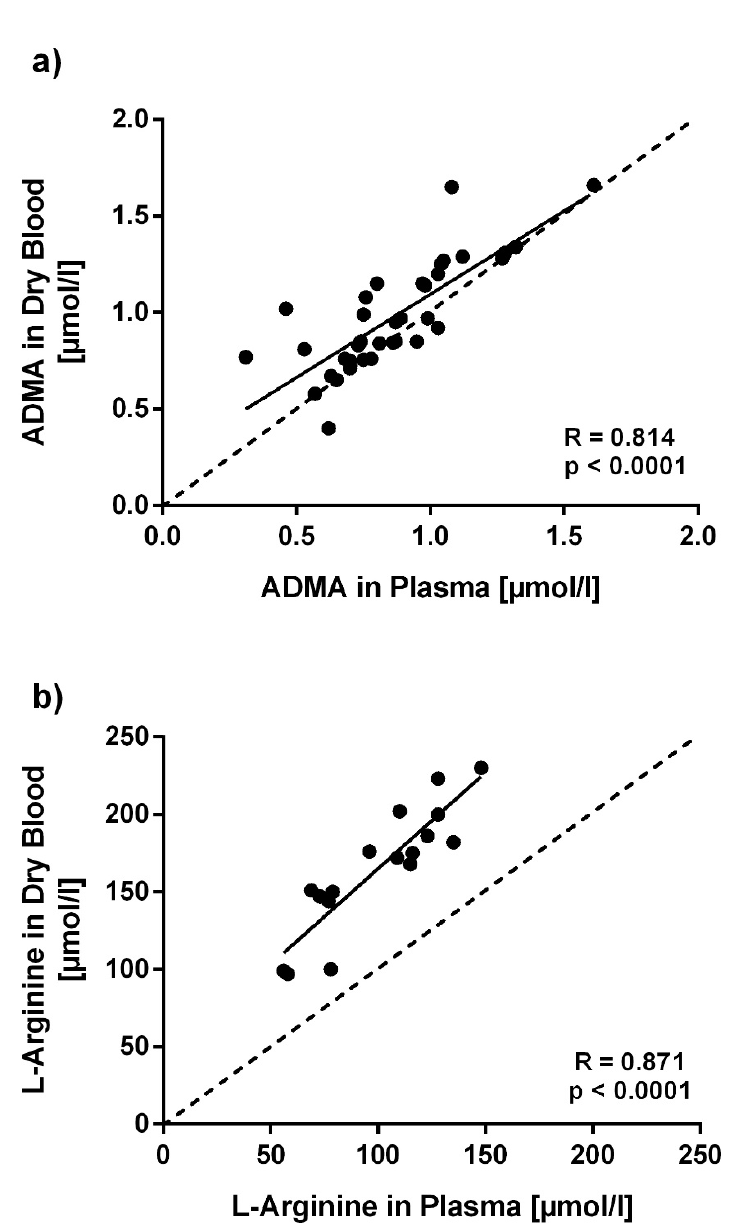
Figure 4. Correlation of ADMA and L-arginine concentrations measured in dried blood spots and in plasma. ADMA ( a ) and L-arginine ( b ) were measured from dried blood spots and plasma samples collected from the same subjects at the same day. Each dot marks one subject’s assay results. The dotted line marks the line of equivalence between both assays. R values represent Pearson’s correlation coefficients.